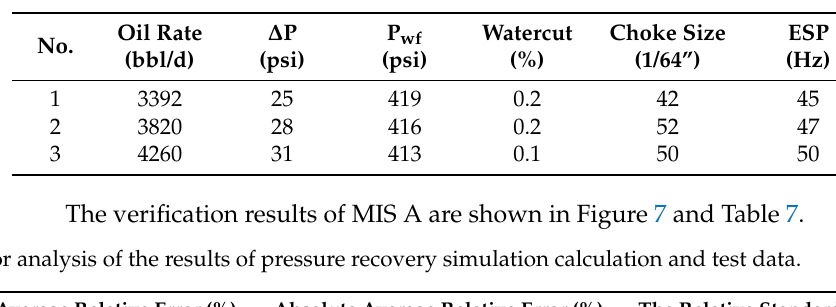
Table 6. Test production data of MIS 322 CN-H2 wells.